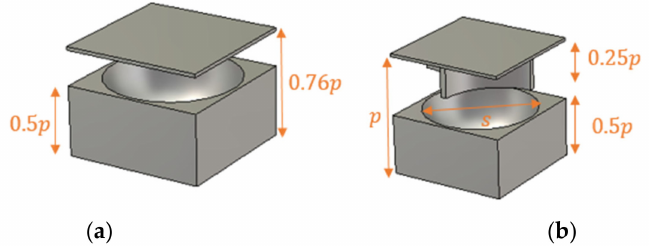
Figure 7. ( a ) Holey and ( b ) holey glide-symmetric unit